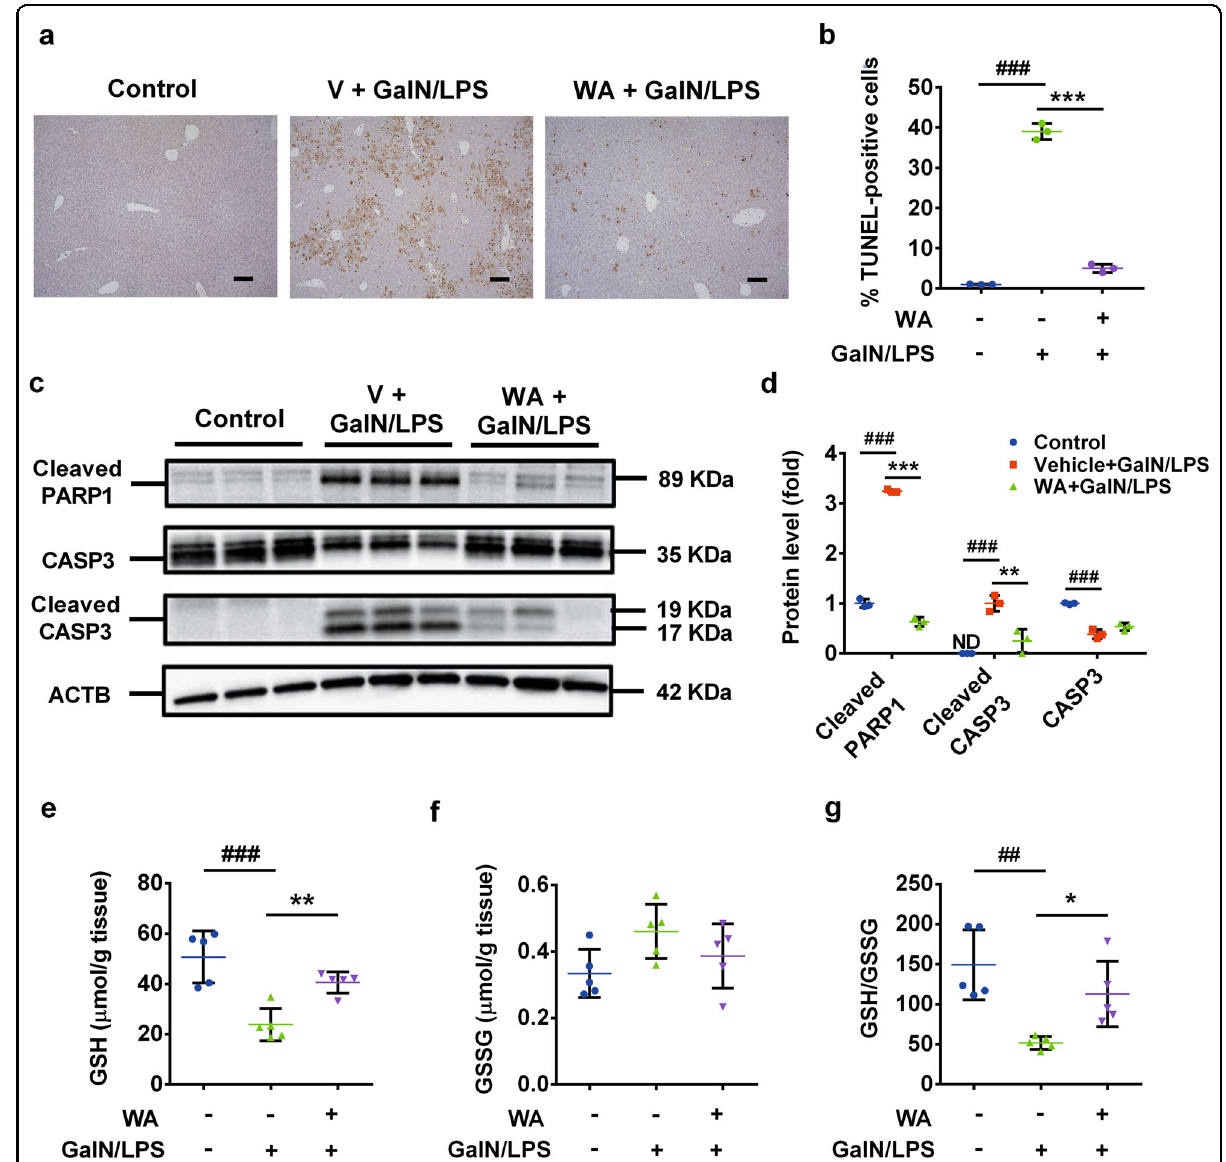
Fig. 3 WA suppressed hepatic apoptosis and alleviated hepatic oxidative stress. a Representative TUNEL staining of liver sections. b Statistical analysis of TUNEL staining ( n = 3). c Western blot analysis of CASP3, cleaved PARP1 and cleaved CASP3 expression. d quantitation analyses of cleaved PARP1, CASP3 and cleaved CASP3 ( n = 3). e Hepatic GSH levels. f Hepatic GSSG levels. g Hepatic GSH/GSSG ratio. Data are presented as means ± SD ( n = 5 unless otherwise indicated). Groups were the same as described in Fig. 1 legend. One-way ANOVA or unpaired two-tailed t test was used for statistical analyses. # p < 0.05, ## p < 0.01, ### p < 0.005 versus Control group; * p < 0.05, ** p < 0.01, *** p < 0.005 versus V + GalN/LPS